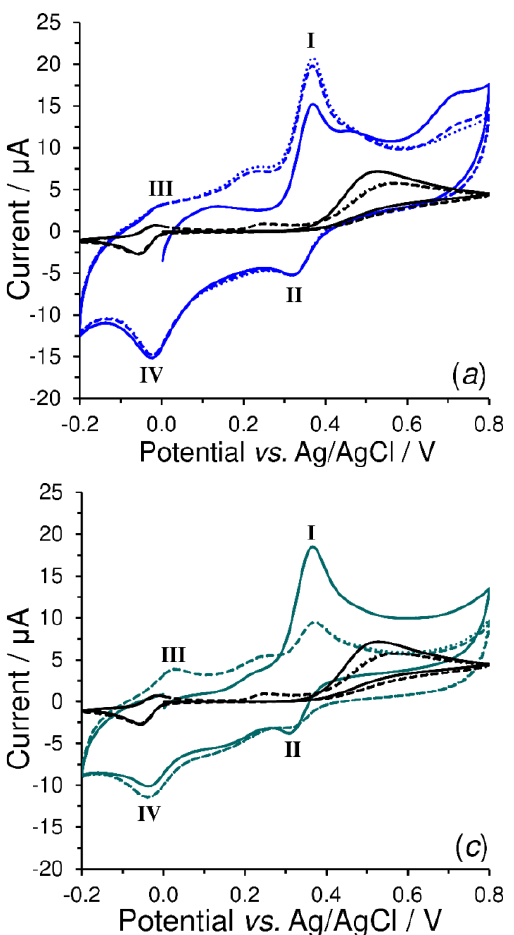
Figure 6. Repetitive cyclic voltammograms (1st cycle; solid, 2nd cycle; dashed and 3rd cycle; dotted curves) of 500 μmol L −1 (±)-epinephrine obtained at bare SPCE (black), SPCE/PV (blue; a ), SPCE/PC (red; b ) and SPCE/P4HB (green curves; c ) in 0.1 mol L −1 AcB (pH 4.5) at E step = 5 mV and ν = 10 mV s −1 . Roman numerals denote the respective peaks (details are given in the text). If the voltammograms recorded in 500 µ mol L − 1 of investigated neurotransmitters (dopamine; a , noradrenaline; b , serotonin; c , and adrenaline; d ) and obtained at bare